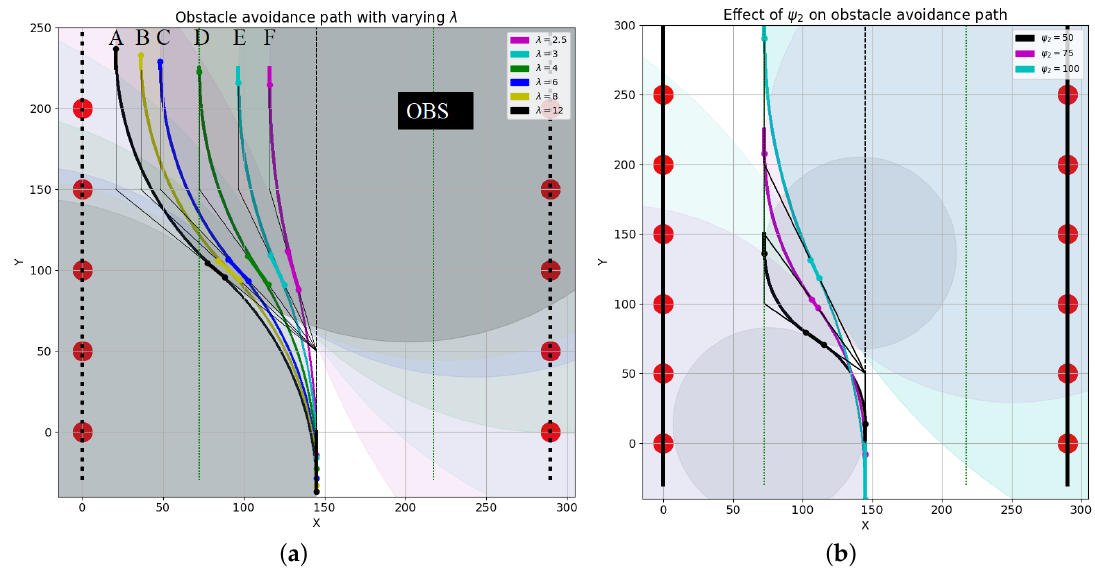
Figure 8. Effects of parameters λ and ψ on trajectories generated. ( a ) Different trajectories generated with different λ values. ( b ) Trajectories generated with different ψ values.